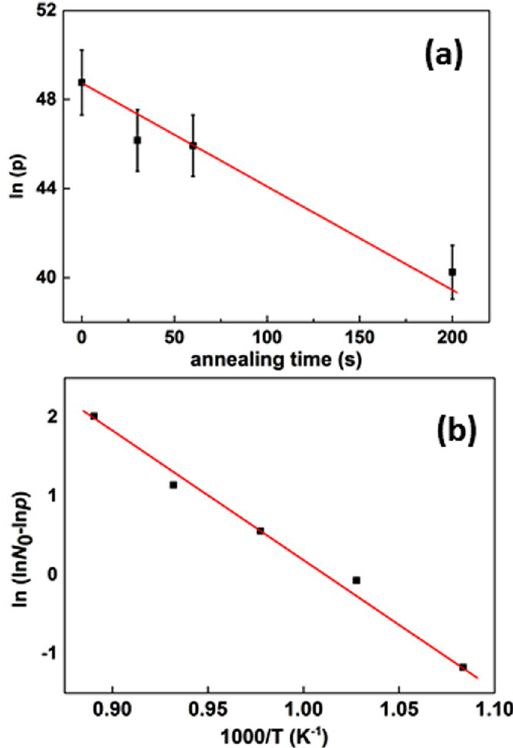
Figure 3. (a) Natural logarithm of the carrier concentration as a function of annealing time for Cu-Cr-O films annealed at a fixed temperature T = 1173 K; (b) Arrhenius plot of the difference of the natural logarithm of carrier concentration and initial doping, − lnN lnp , as a function of the annealing temperature for CuCrO 2 0 annealed during a fixed time t = 900 s. The size of error bar is comparable with the symbol ‘size. Red lines: linear fits to the